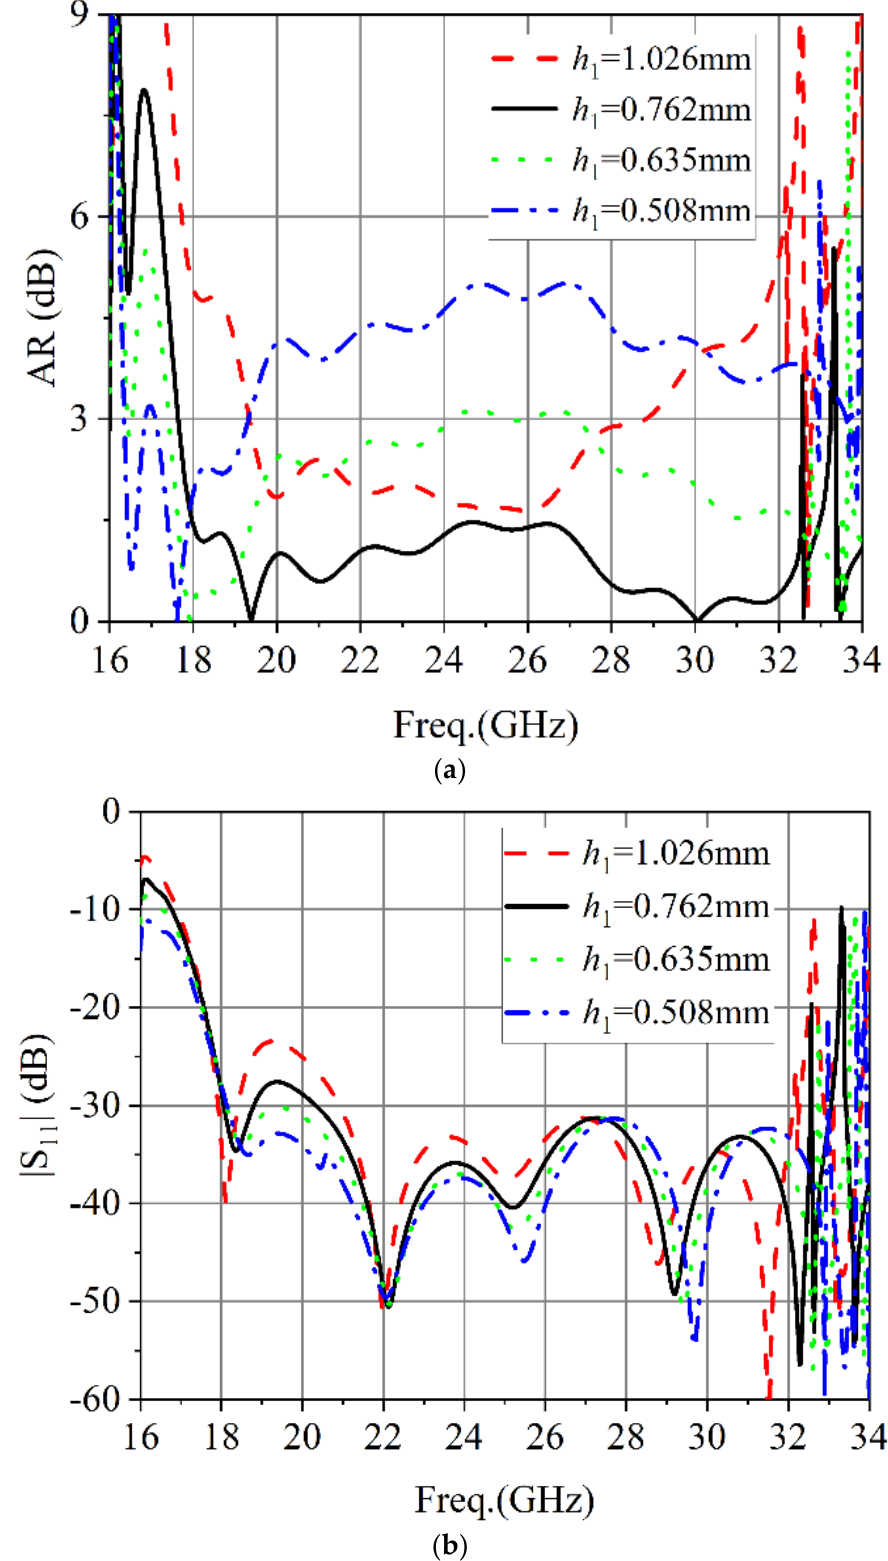
Figure 7. Simulated results of different dielectric plate thickness: ( a ) AR. ( b ) |S 11 |.